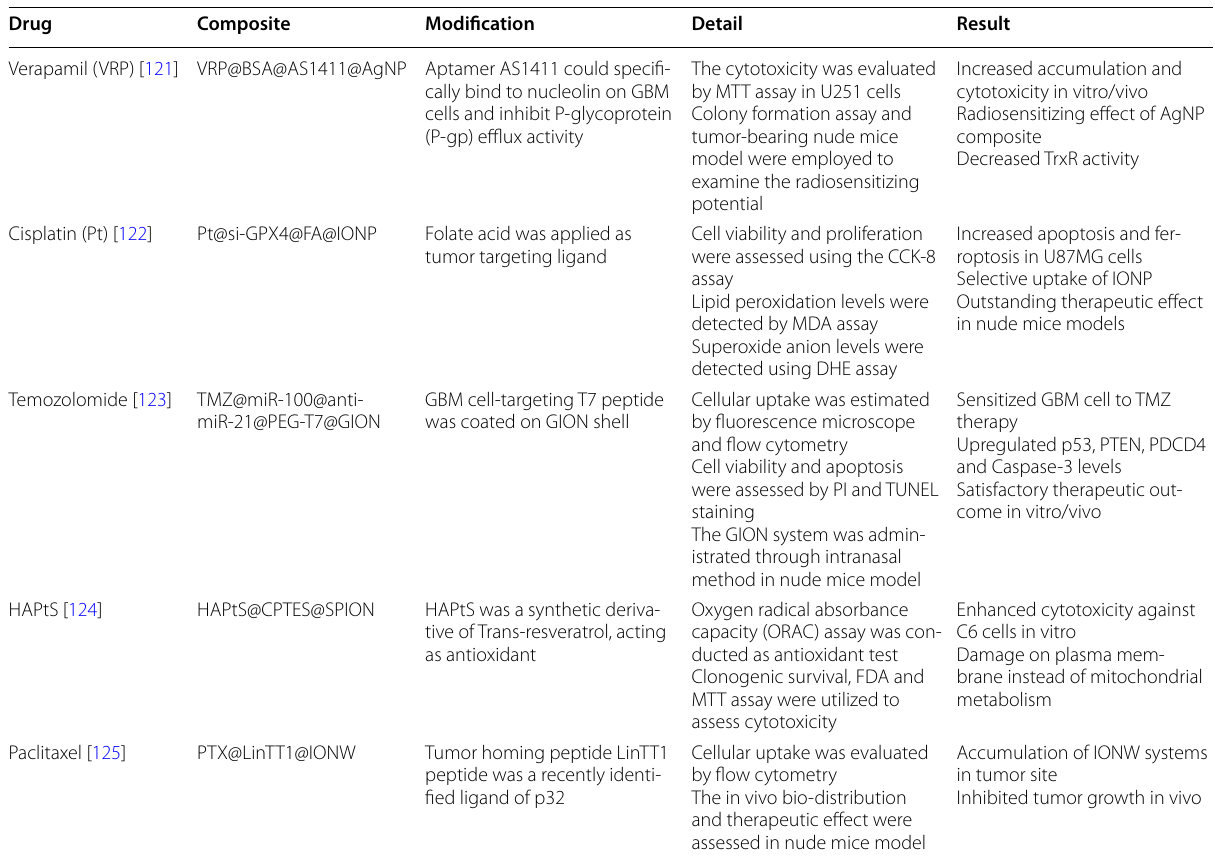
Table 4 Metal nanoparticle based anti-GBM drug delivery system